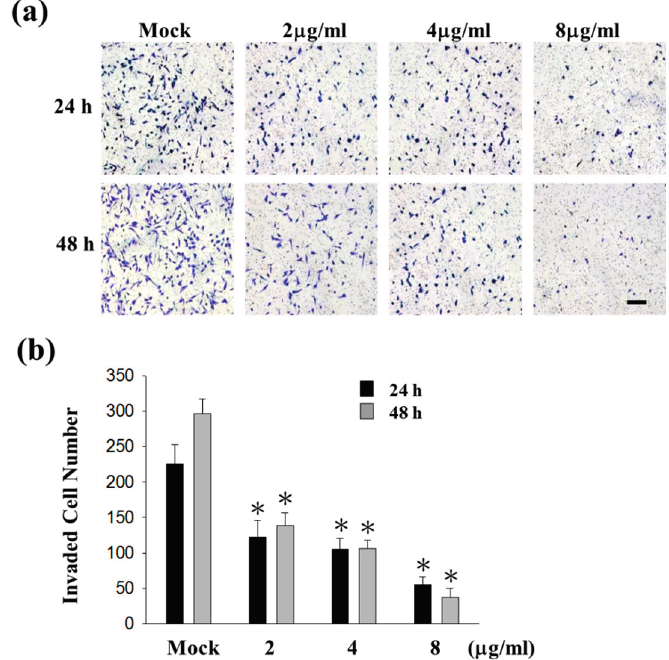
Figure 1. The anti-migratory effects of sinulariolide in HA22T cells. ( a ) After 24 and 48 h treating with sinulariolide, migrated HA22T cells were clearly reduced compared to control cells at the 100× magnification vision. The results shown are representative of three independent experiments. Scale bars = 20 μ m. Mock: control, the DMSO-treated cell; ( b ) Quantitative analysis of figure ( a ) showed that sinulariolide dose-dependently suppresses HA22T cell migration (# p < 0.05, * p < 0.001 compared with the control); ( c ) Representative images of monolayer scratch assays supported that sinulariolide inhibited the migratory potential of HA22T cells.